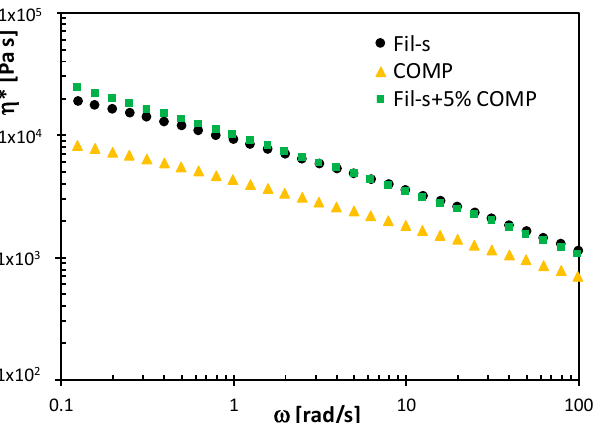
Figure 5. Comparison between the complex viscosity plots of Fil-s, COMP and Fil-s + 5%COMP. In the whole frequency range investigated, the compatibilizer exhibits η * values significantly lower compared with Fil-s, and its addition inside the recyclate makes more pronounced its shear thinning behaviour, evidencing for the compatibilized material an even better processability by extrusion. The inter-polymer (both PE-PE or PP-PP and PE-PP) polar interactions between anhydride groups in the compatibilized Fil-s contribute to this outcome [26]. However, a similar effect on the complex viscosity could also be attributed to an increase of cross-linking and/or branching degree in the recyclate due to COMP addition [33].